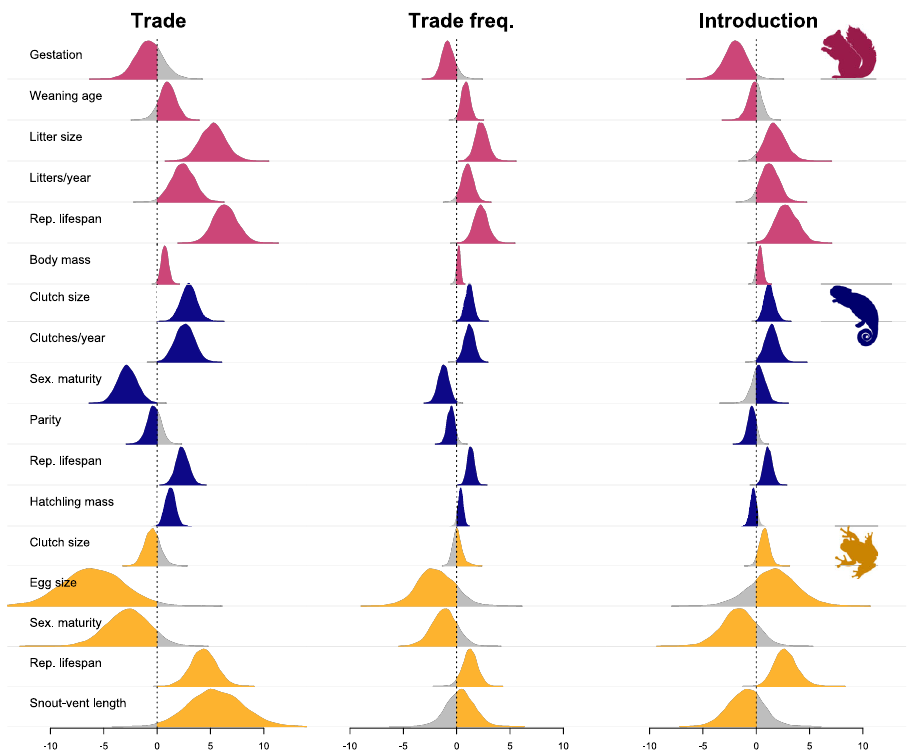
Fig. 1 | Effects of life history traits on trade, trade frequency and introduction. Posterior distributions of fi xed effect estimates from models based on US live wildlife trade data, for effects of life history traits on trade probability (traded vs. non-traded species) and trade frequency (N shipments per species) from hurdle